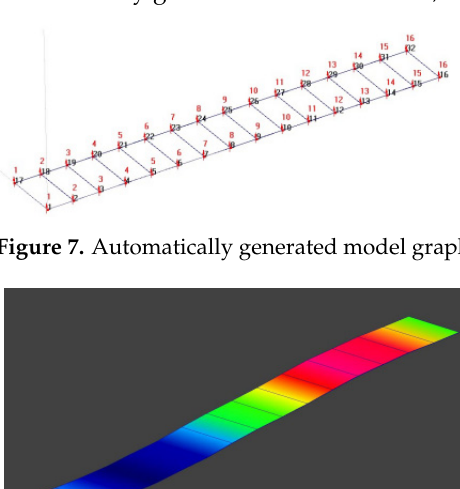
Figure 7. Automatically generated model graph.